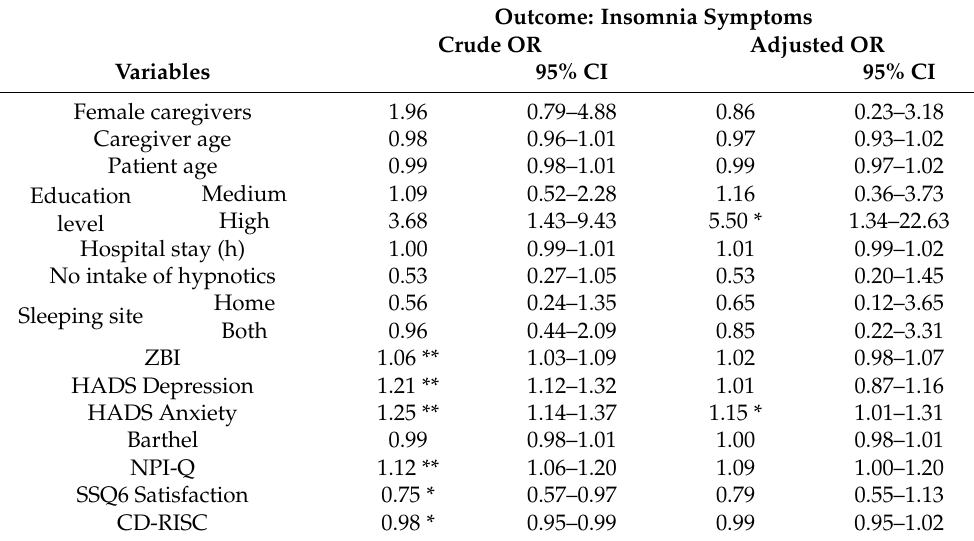
Table 3. Crude and adjusted associations between the baseline variables of informal caregivers and the presence of insomnia